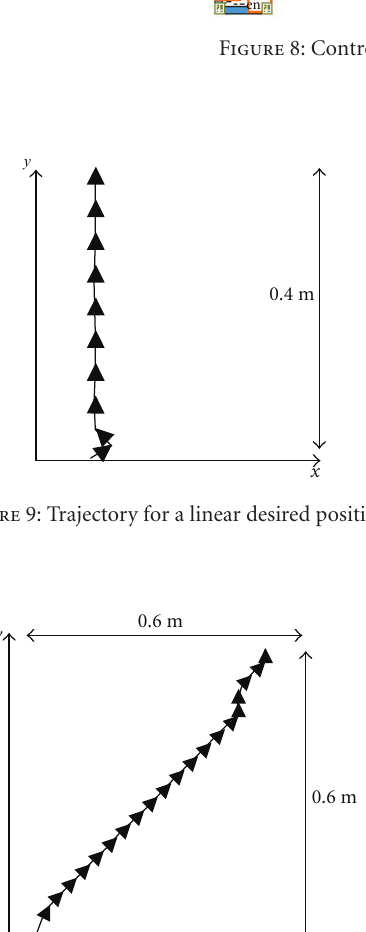
u 1 / = 0, u 2 = 0. (d) The robot can remain static and the vector u has 0 values. (e) A movement forward takes place if the vector is positive. (f) A movement backward takes place if the vector is